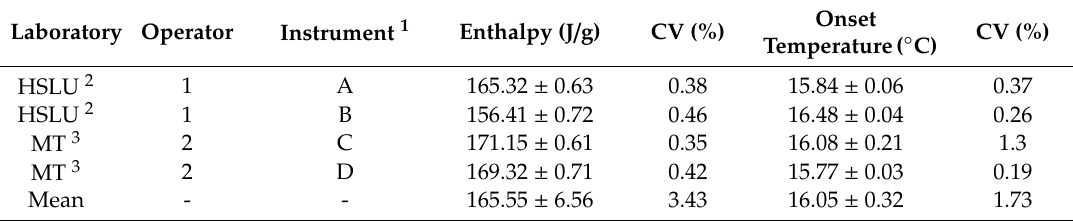
Table 2. Comparability of method used by di ff erent operators and instruments for Crodatherm 17 / DEV 2067. On each instrument, at least four and up to eight runs of the procedure described in Section 2.2 are considered. The mean ± standard deviation and the coe ffi cient of variation are given for each set of measurements.